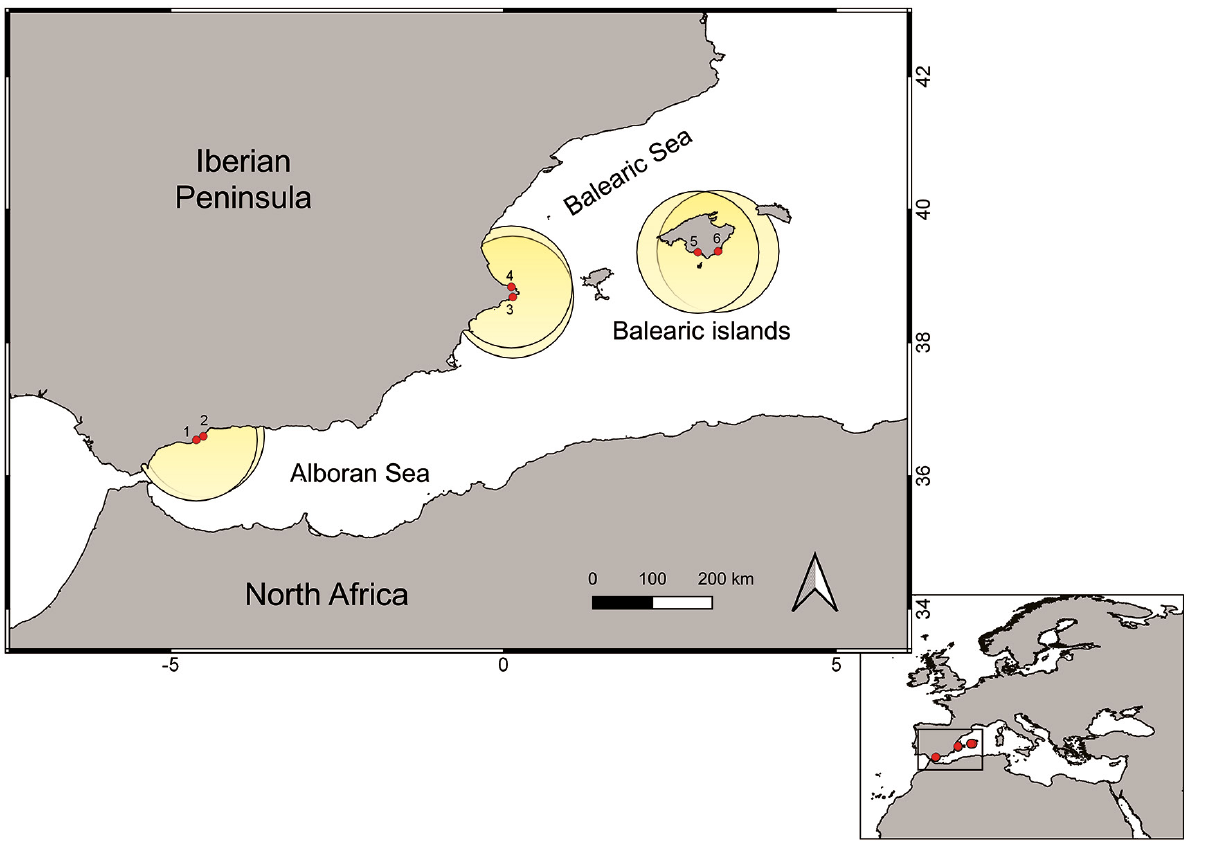
Fig. 1. – The western Mediterranean Sea showing the fishing grounds of recreational fishery (circles around the base ports) during the fishing tournaments. Base ports. Alboran Sea (Area 2): 1, Fuengirola; 2, Benalmadena. Balearic Sea (Area 1): 3, Moraira; 4, Denia; 5 S’Estanyol; 6, Cala